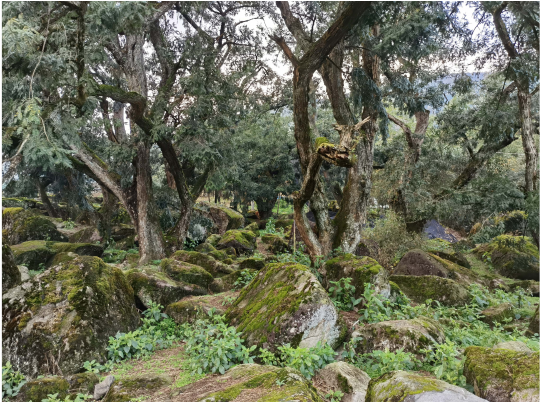
Figure 3. The landscape consisting of collapsed boulders and Chinese Torreya trees in Baiyankeng village (photographed by a village helper in November 2021).